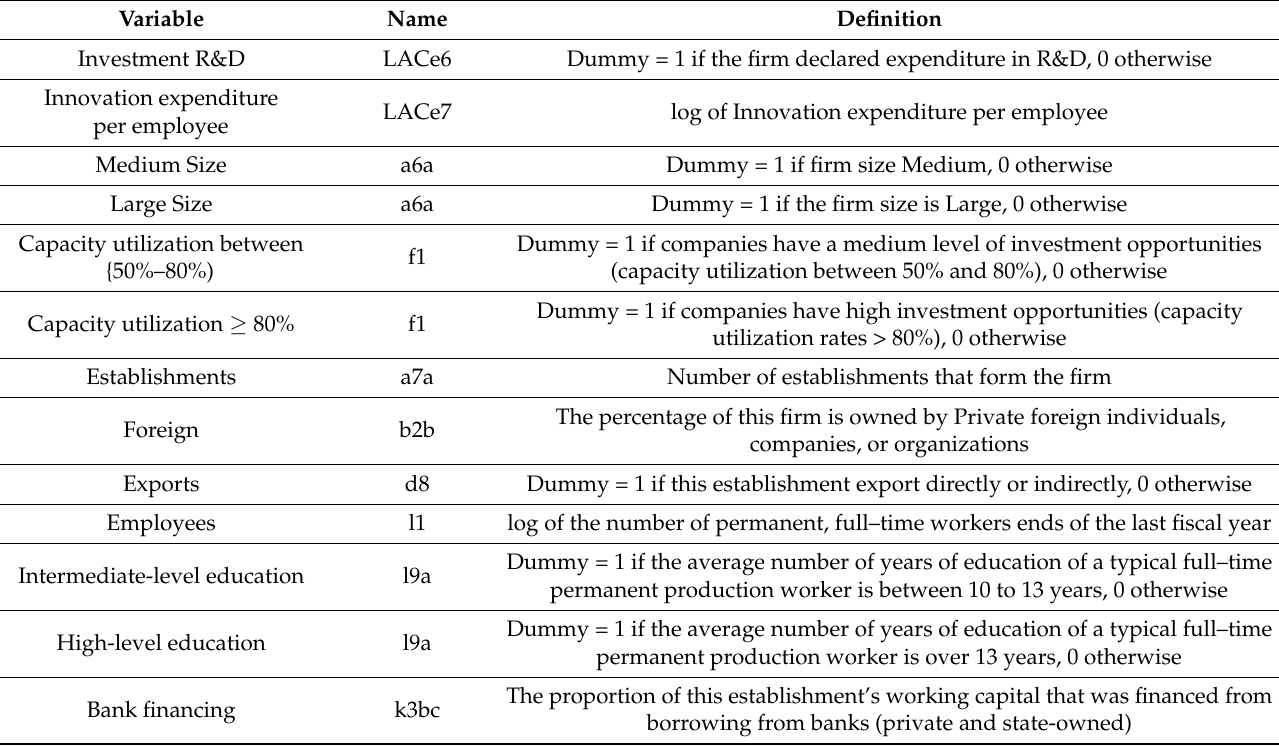
Table 4. Definition of variables used in this